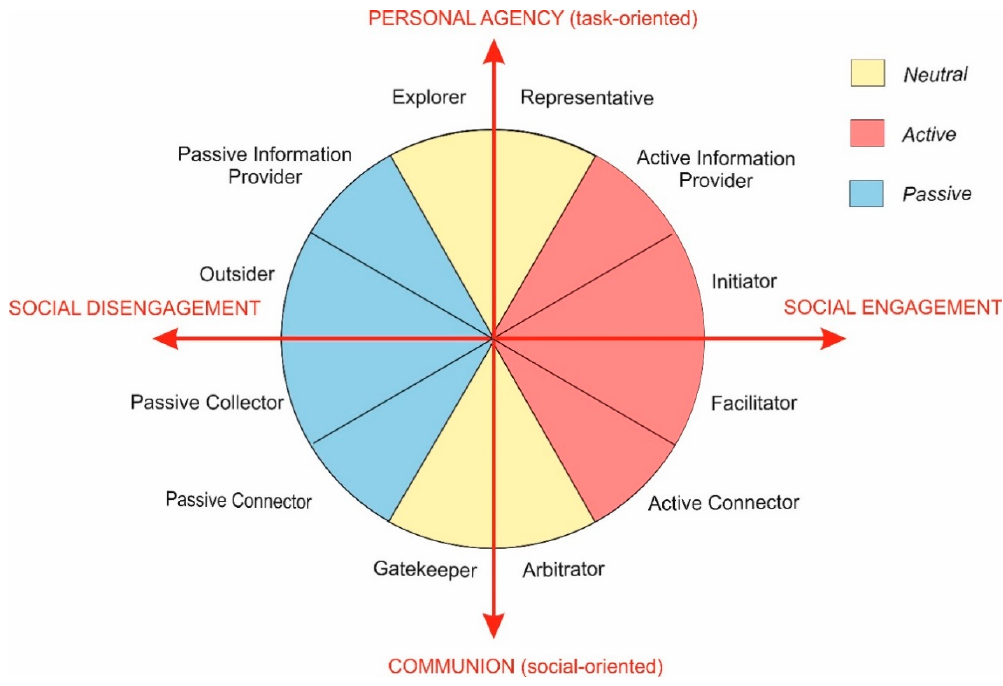
Figure 3. Circumplex of team roles. Red colour roles: Active Information Provider, Initiator, Facilitator and Active Connector. The red colour in Figure 3 symbolizes team roles with high communication activity (Social